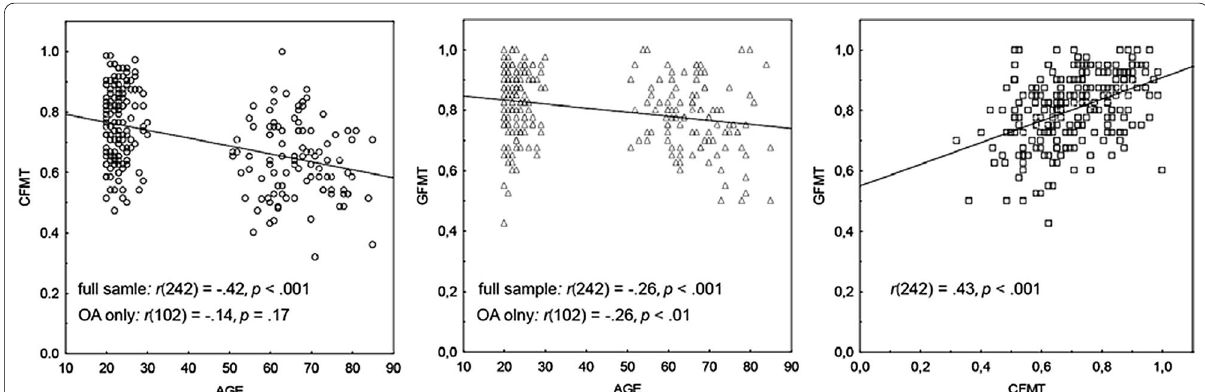
Fig. 2 Scatterplots showing relationships between Age and the Cambridge Face Memory Test (CFMT) (left), between Age and the Glasgow Face Matching Test (GFMT) (middle) and between the CFMT and GFMT (right). r Pearson’s correlation coefficient for the full sample and for older adults = (OA) only. r is not reported for YA because of the very narrow age‑range for this group. Spearman’s rank correlations are provided in Additional file 1: Tables 1,